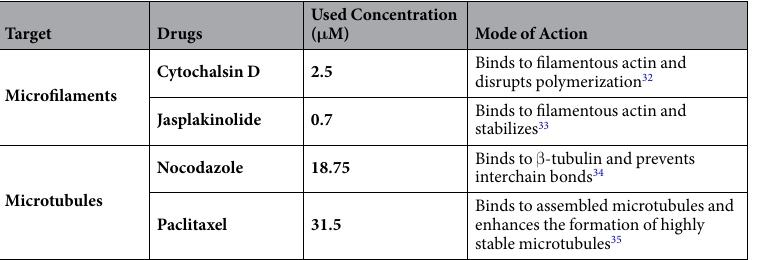
Table 1. Summary of drugs targeting the cytoskeleton and their mode of